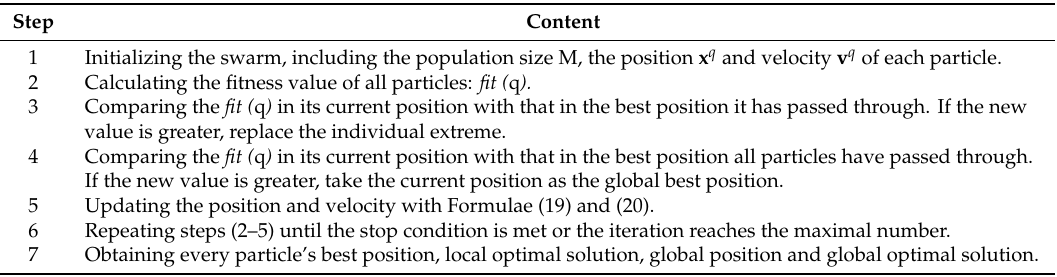
Table 1. The particle swarm optimization (PSO)